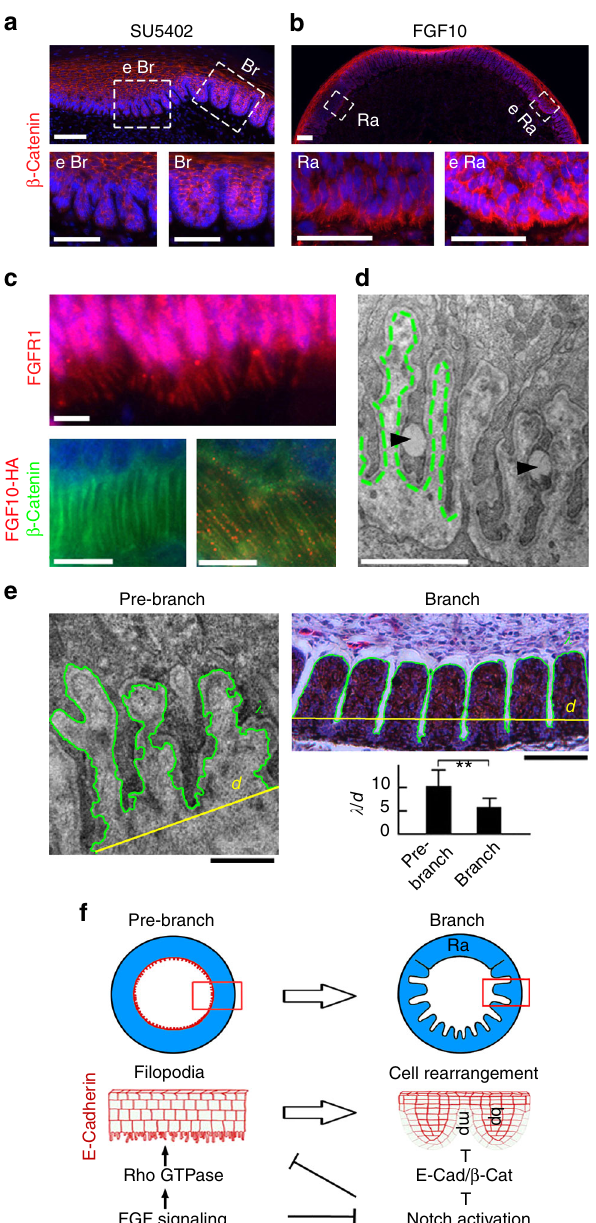
Fig. 7 The fi lopodia sense and transport FGF10 and increase the surface area for feather branching. a SU5402 induced ectopic branch (eBr) in the rachis and inhibited fi lopodia. b Locally implanted FGF10 beads inhibited branching and induced fi lopodia in basal keratinocytes. c Filopodia expressed FGFR1, and transported FGF10. Notice the FGF10 puncta (red) were lined up along the fi lopodia (green). d A TEM image showing the transported vesicles inside the fi lopodia (marked by arrowheads). Dashed green line indicated the basal lamina. e The circumference ( λ ) and distance ( d ) of the epithelial — mesenchymal border were measured, and their ratio was calculated. Ten follicles were analyzed and representative images are shown. **, p < 0.01 by t -test. f Schematics showing FGF signaling cooperates with periodic Notch activation to regulate the fi lopodia and E- Cadherin/ β -Catenin-mediated cell adhesion, which then control the periodic feather branching. Β ar = 50 μ m in a , b , e; 10 μ m in c ; 2 μ m in